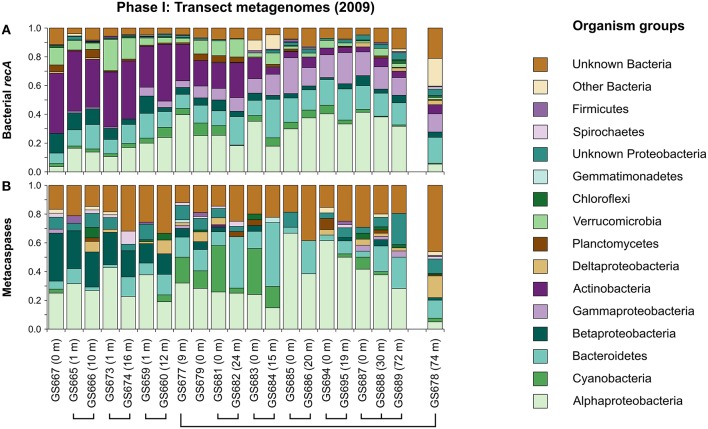
Taxonomic distribution of bacterial recA (A) and metacaspase genes (B) in metagenomes derived along the 2009 Baltic Sea transect (Phase I; 21 stations; Dupont et al., 2014). The relative proportion of sequences from each sampling station (GS number) is displayed (the three non-viral size fractions combined). The taxonomic distribution at Landsort Deep (GS678) is displayed separately as this station represents an outlier (e.g., due to a low-oxygen environment). Sampling stations at the same geographical location (see Figure 1), but at different depths (shown within parentheses), are connected with lines.